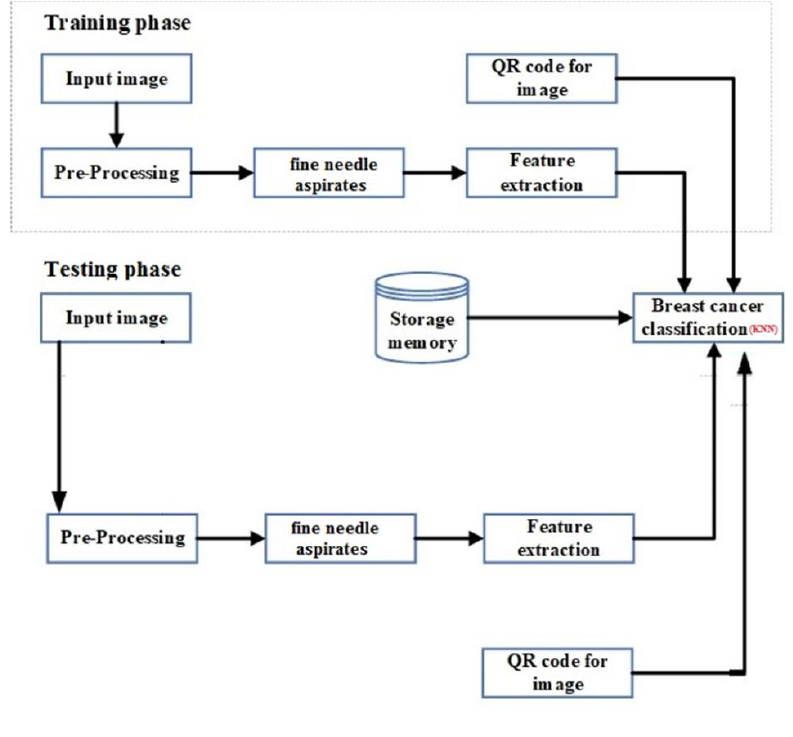
Figure 1. Proposed